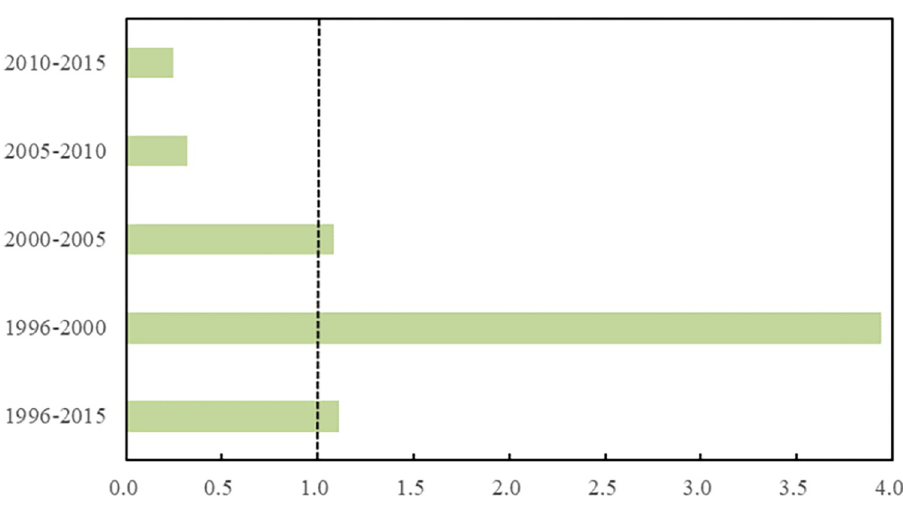
Fig 3. Decoupling stability index of carbon emission in civil aviation in different time